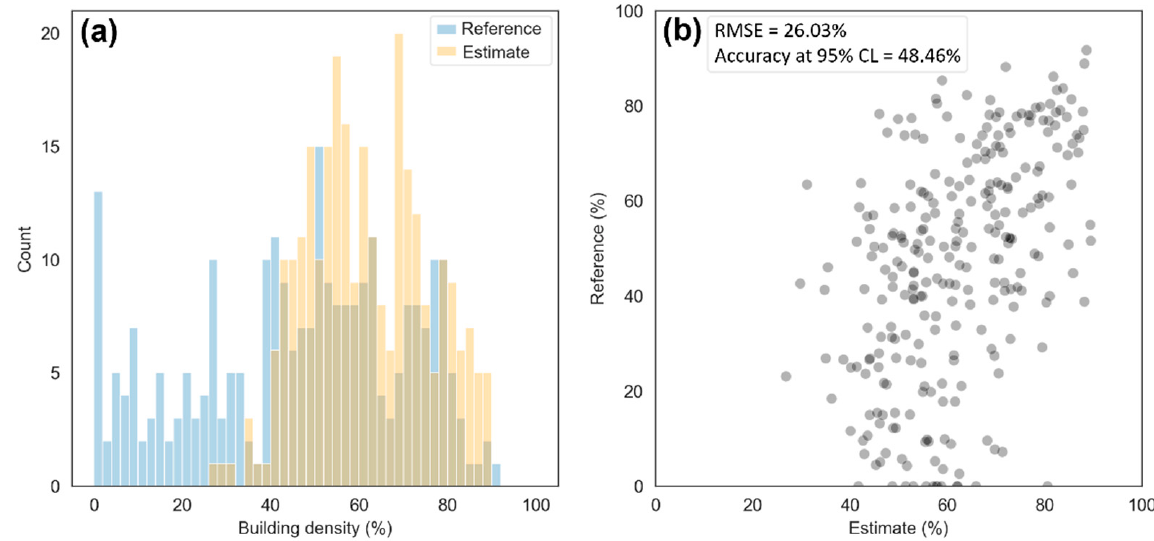
Figure 8. Comparison of the distribution between reference data and estimated building density in the image of 2002, plotted as ( a ) histograms and ( b ) a scatterplot. Since the model was not satisfactorily applied for Landsat 5/7, we remodeled the building density using the training samples of 2003 applied on Landsat 7 acquired in 2002. Samples were split, i.e., 220 and 50 samples for building the model and testing, respectively. As the modeling used different reference data, the best parameters were also assessed separately. The best RFR models are with 500 and 200 ntrees for the inputs of all indices and UI-NDBI-IBI, respectively. For SVR, the best parameters for modeling are C = 1 and gamma = 0.2 for all indices, and C = 10 and gamma = 0.1 for UI-NDBI-IBI. In contrast to Landsat 8, the high accuracy models using Landsat 7 are dominated by LR methods (Figure 9), with the best model using the predictor of UI (RMSE = 20.48%, accuracy = 62.76%), followed by all indices (RMSE = 21.32%, accuracy = 61.25%), NDBI (RMSE = 21.52%, accuracy = 60.85%), UI-NDBI-IBI (RMSE = 21.54%, accuracy = 60.84%), and IBI (RMSE = 21.54% accuracy = 60.84%). The least accurate models are RFR